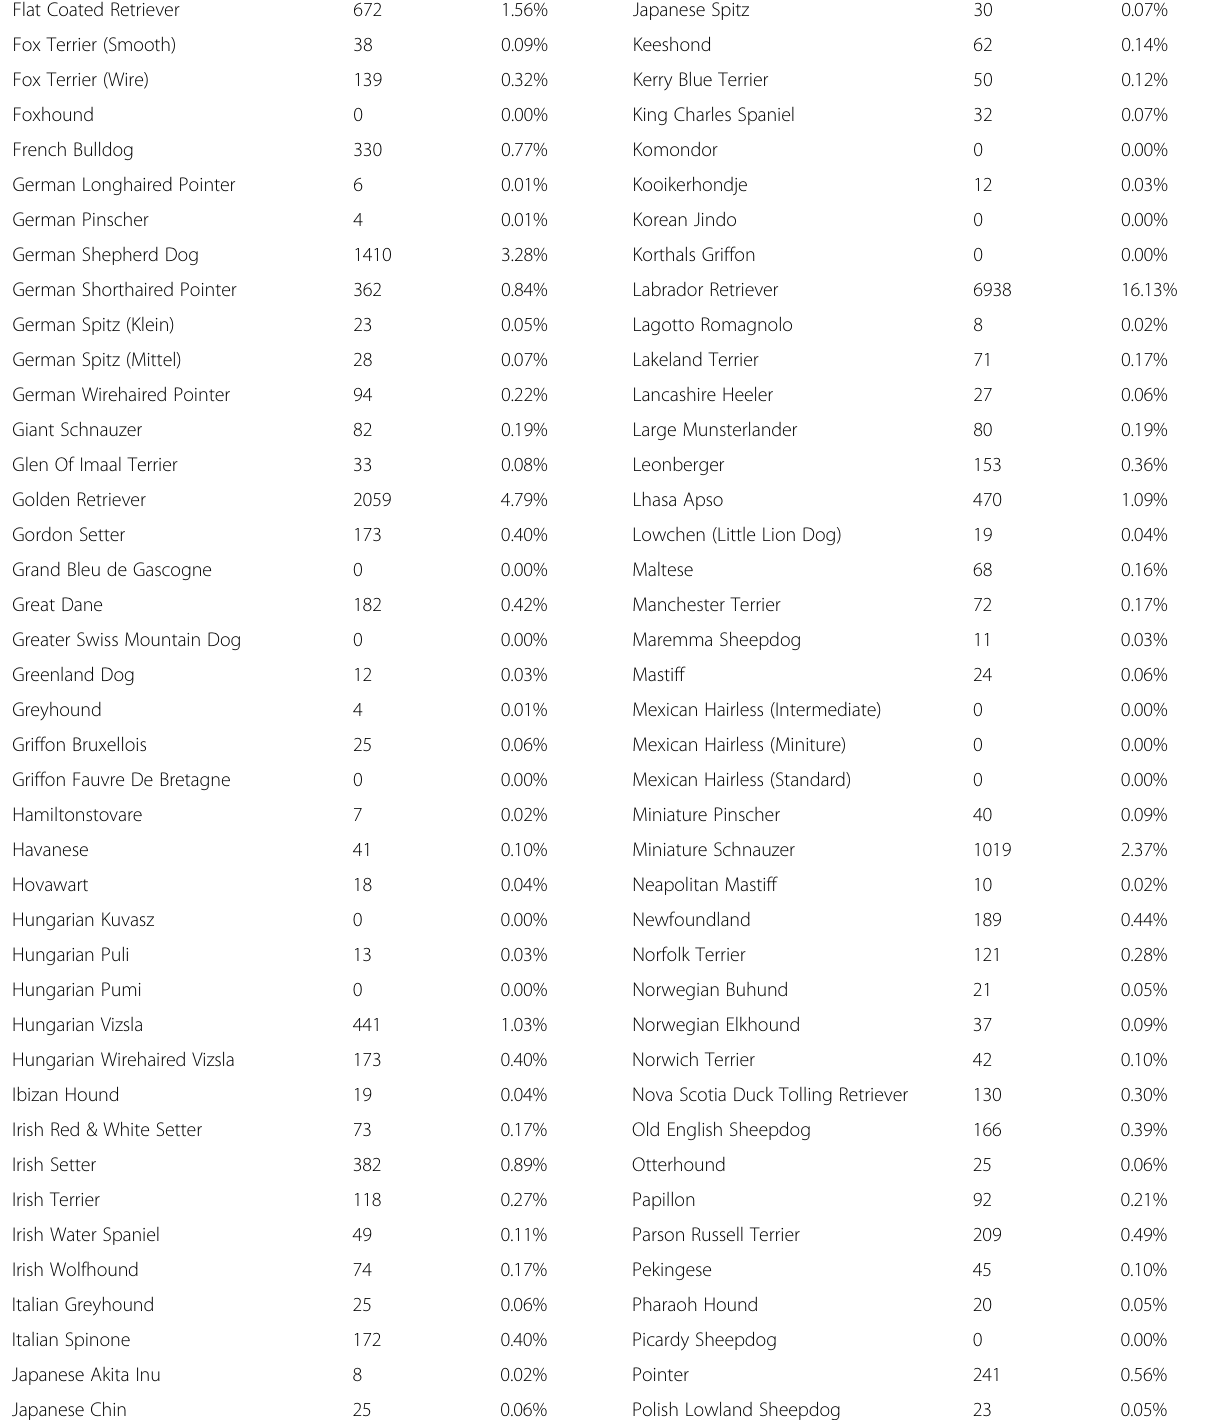
Table 1 Number of unique individual dogs for which responses were received and approximated response rate (from total number registered from 2004 – 13 inclusive) for all breeds (Continued)